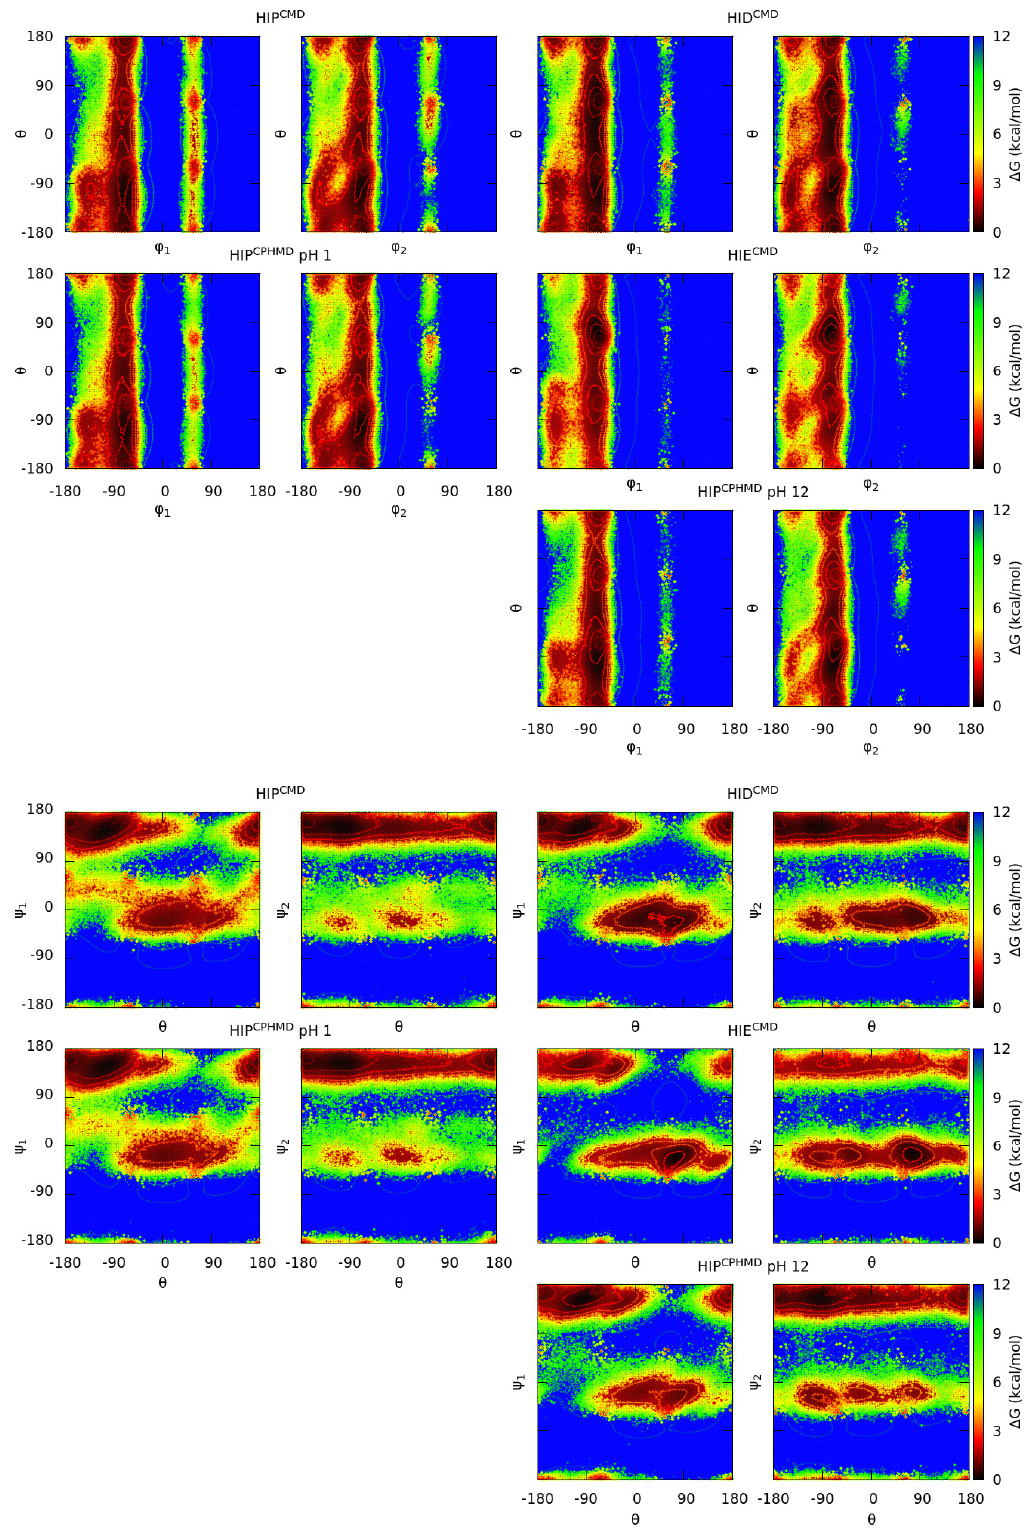
Figure 12. Gibbs free energies in the side chain-orientation space of the blocked His 2 tripeptide. Each subtitle indicates the residue, the simulation method (in the superscript), and the pH (only for the CPHMD simulations). Four sets of dihedral angles are used in this plot, using the θ dihedral angle (CE1-CA-CA-CE1) in conjunction with the phi ( ϕ ) or psi ( ψ ) of each monomer ( ϕ 1 / ψ 1 from the N-terminal amino acid; ϕ 2 / ψ 2 from the C-terminal amino acid). Protonated forms are on the left and deprotonated ones are on the right. Solid lines indicate an increase of 0.6 kcal/mol of the energy